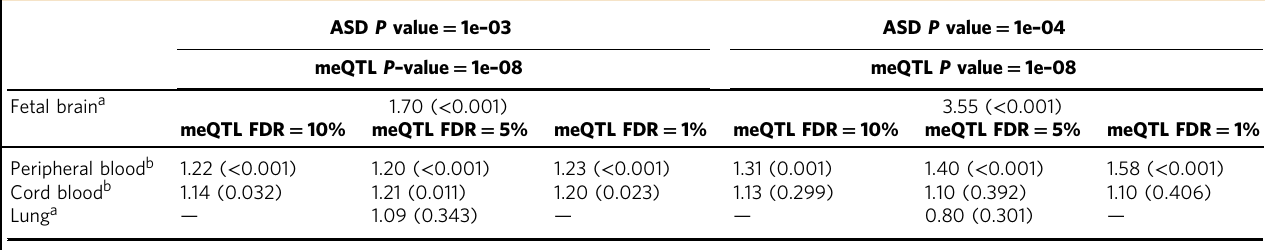
Table 2 Enrichment statistics for meQTLs derived from 4 tissue types in ASD GWAS SNPs